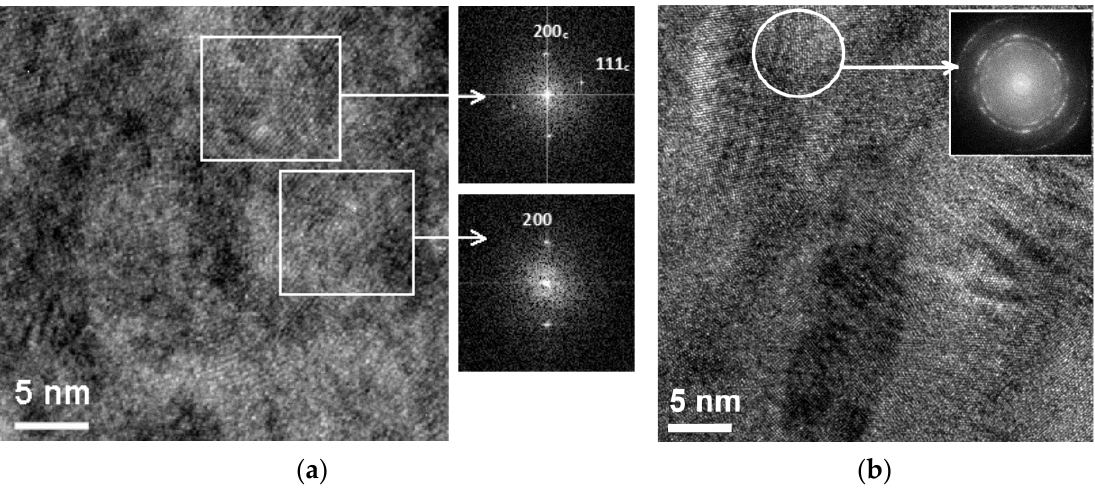
Figure 1. TEM image of the (TiAlCrSiY)N layer ( a ) and the (TiAlCr) layer ( b ) of the nanolaminate coating.